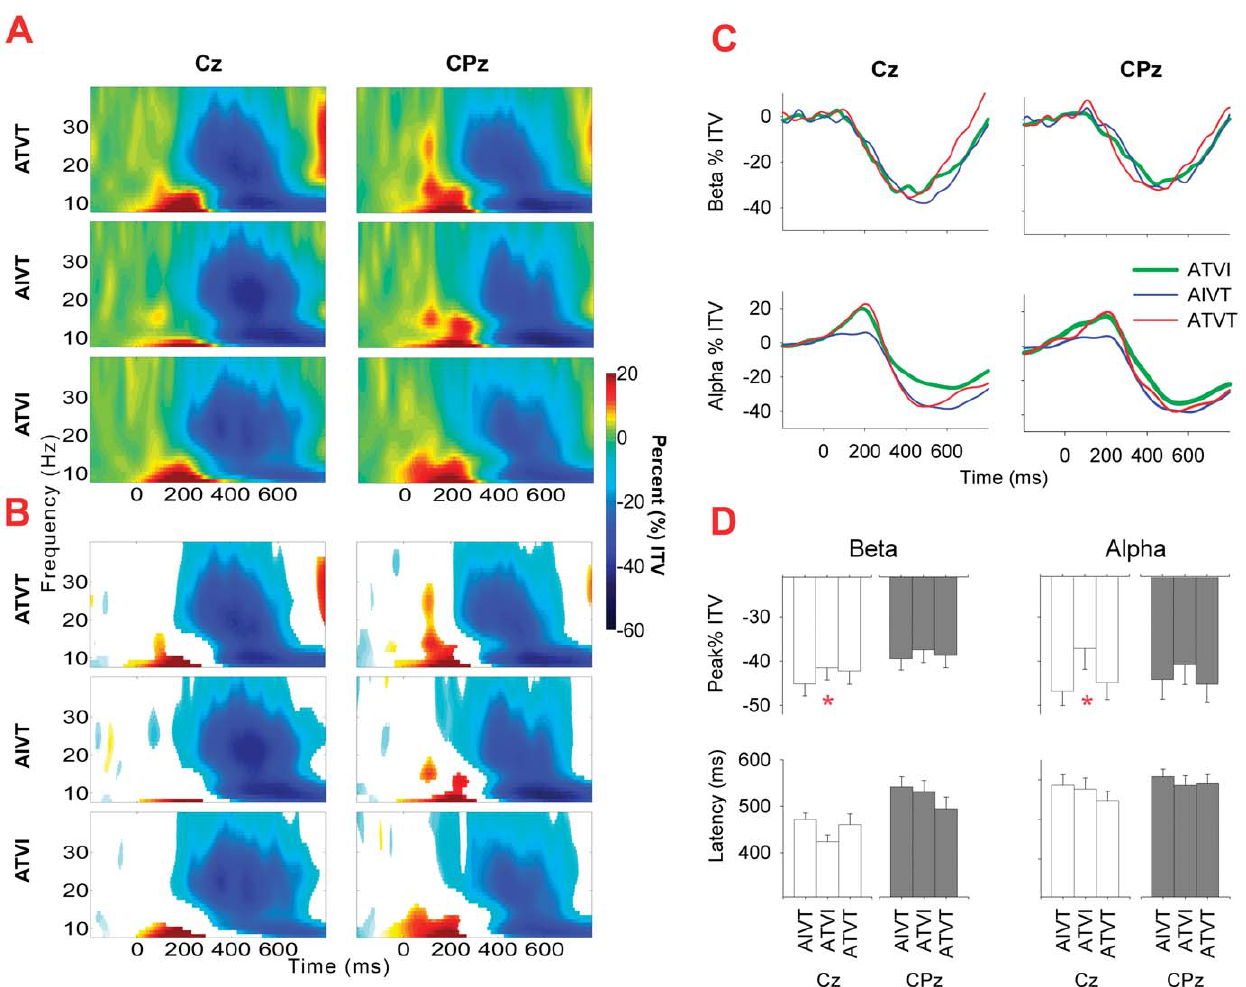
Figure 6. Inter-trial variance for audiovisual stimuli at central electrode sites. A . For the central electrode sites Cz and CPz, percentage (%) of increase and decrease in inter-trial variance (ITV) in the 8–40 Hz frequency range for ATVI (auditory target and visual irrelevant), AIVT (auditory irrelevant and visual target) and ATVT (audiovisual dual target) stimuli. B . For each stimulus type at Cz and CPz, non-significant ( p . .01 determined using a bootstrap procedure) changes in inter-trial variance (ITV) from the baseline are occluded using a white mask. C . Mean alpha (8–13 Hz) and beta (14–30 Hz) inter-trial variance (ITV) across time for electrodes Cz and CPz. D . Mean amplitude and latency of peak minima ( + SEMs ) in the alpha and beta frequency range for Cz and CPz electrodes (* p , .05 for one-way